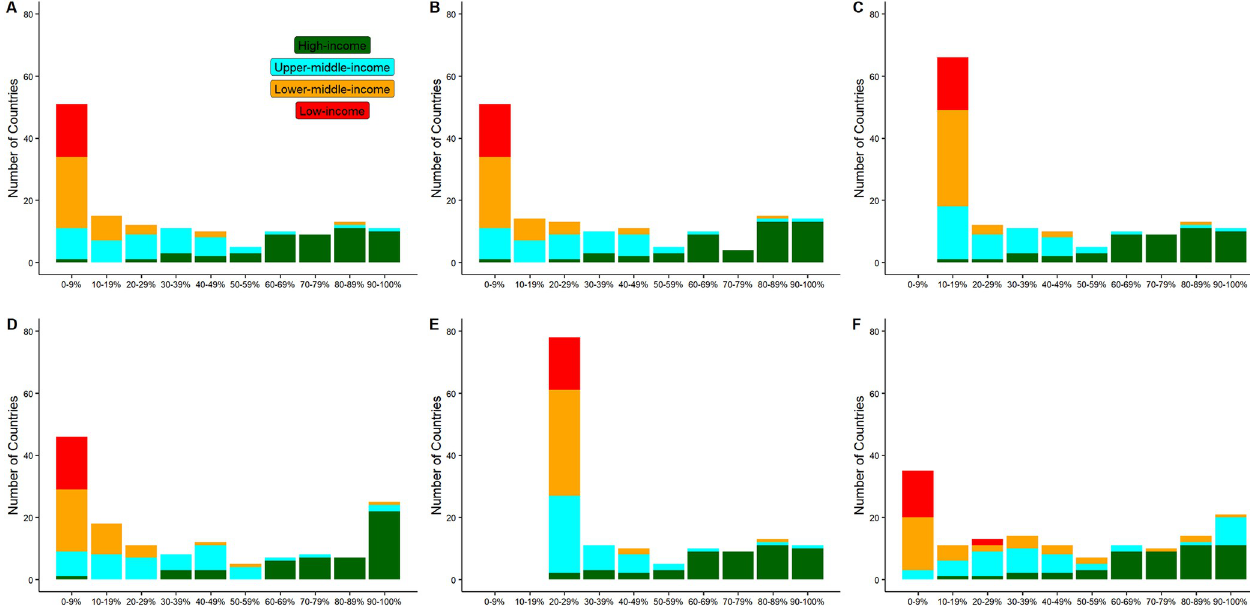
Fig 3. Number of countries by vaccination rate by the end of the projection period. (A) baseline. All countries continue their current vaccination progress for the projection period of three months. No additional vaccines. (B) 1.11 million additional vaccines every day are distributed per current global distribution. (C) 1.11 million additional vaccines every day are distributed to achieve a minimum vaccination rate of 10% for all countries. (D) 5.00 million additional vaccines every day are distributed per current global distribution. (E) 5.00 million additional vaccines every day are distributed to achieve a minimum vaccination rate of 26% for all countries. (F) 5.00 million additional vaccines every day are distributed per national projected cases.